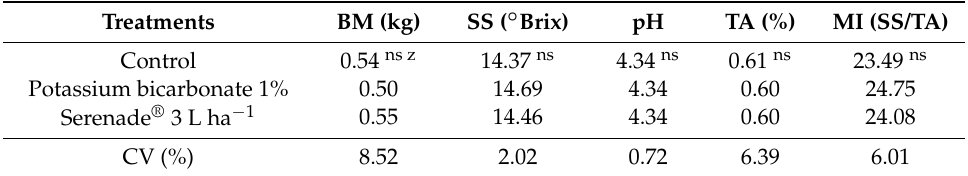
Table 2. Bunch mass (BM), soluble solids content (SS), pH, total acidity (TA), and maturation index (MI − SS/TA) ratio recorded in ‘BRS Isis’ seedless table grapes subjected to different preharvest treatments.